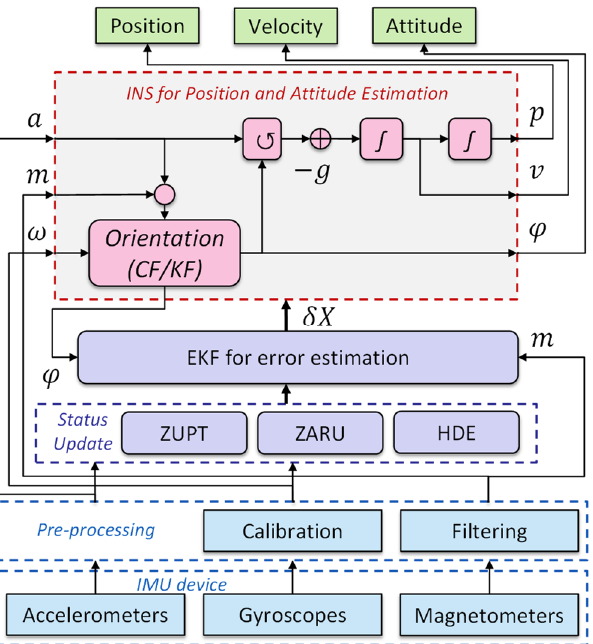
Figure 4. Traditional inertial tracking system. a : acceleration; m : magnetic field; ω : angular rate; p : position; v : velocity; φ : attitude; δX : estimated error. Abbreviations: ZARU: Zero Angular Rate Update; HDE: Heuristic Drift Elimination.